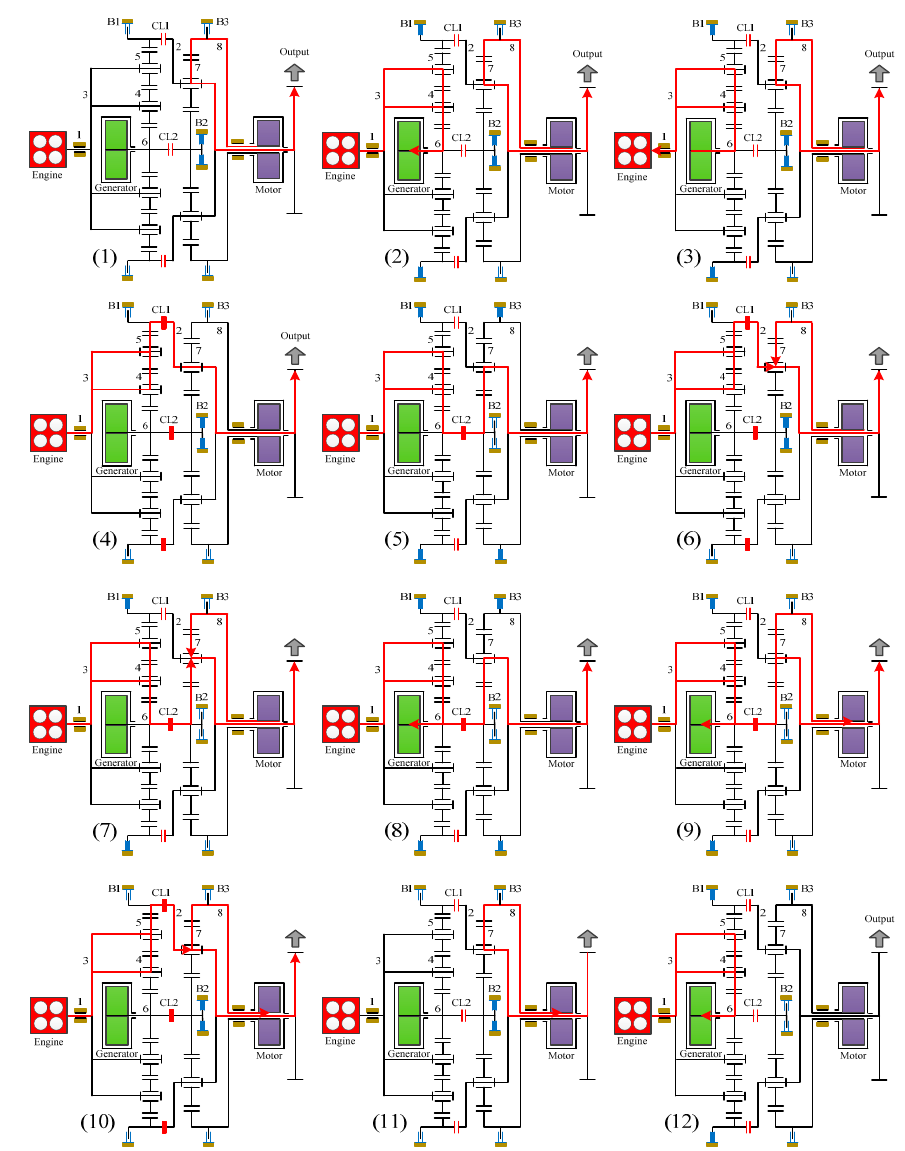
Figure 11. Operation modes of the novel series-parallel hybrid transmission. Table 2. Operation modes and clutching conditions.